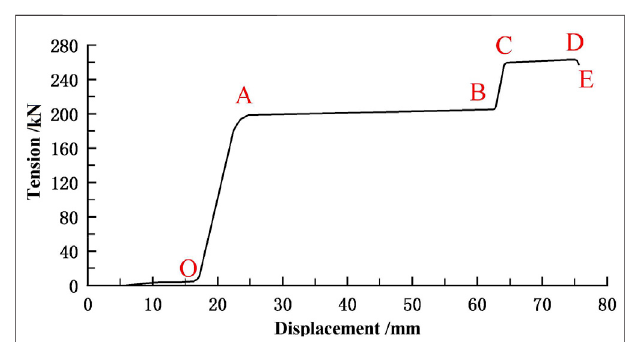
FIGURE 3 | Load-displacement curve under static